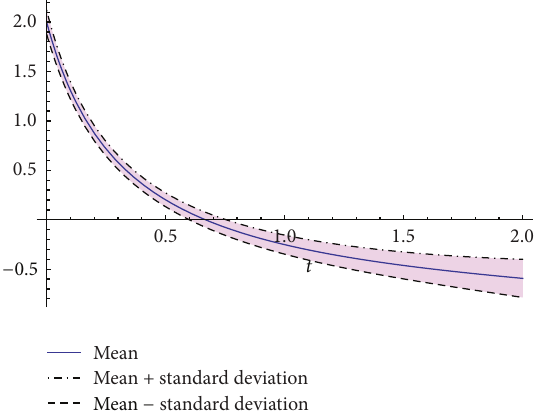
Figure 7: Approximations of the expectation (solid line) and plus/minusstandarddeviation(dashedlines)tothesolutions.p. 𝑦(𝑡) on the interval [0, 2] in Example 5.